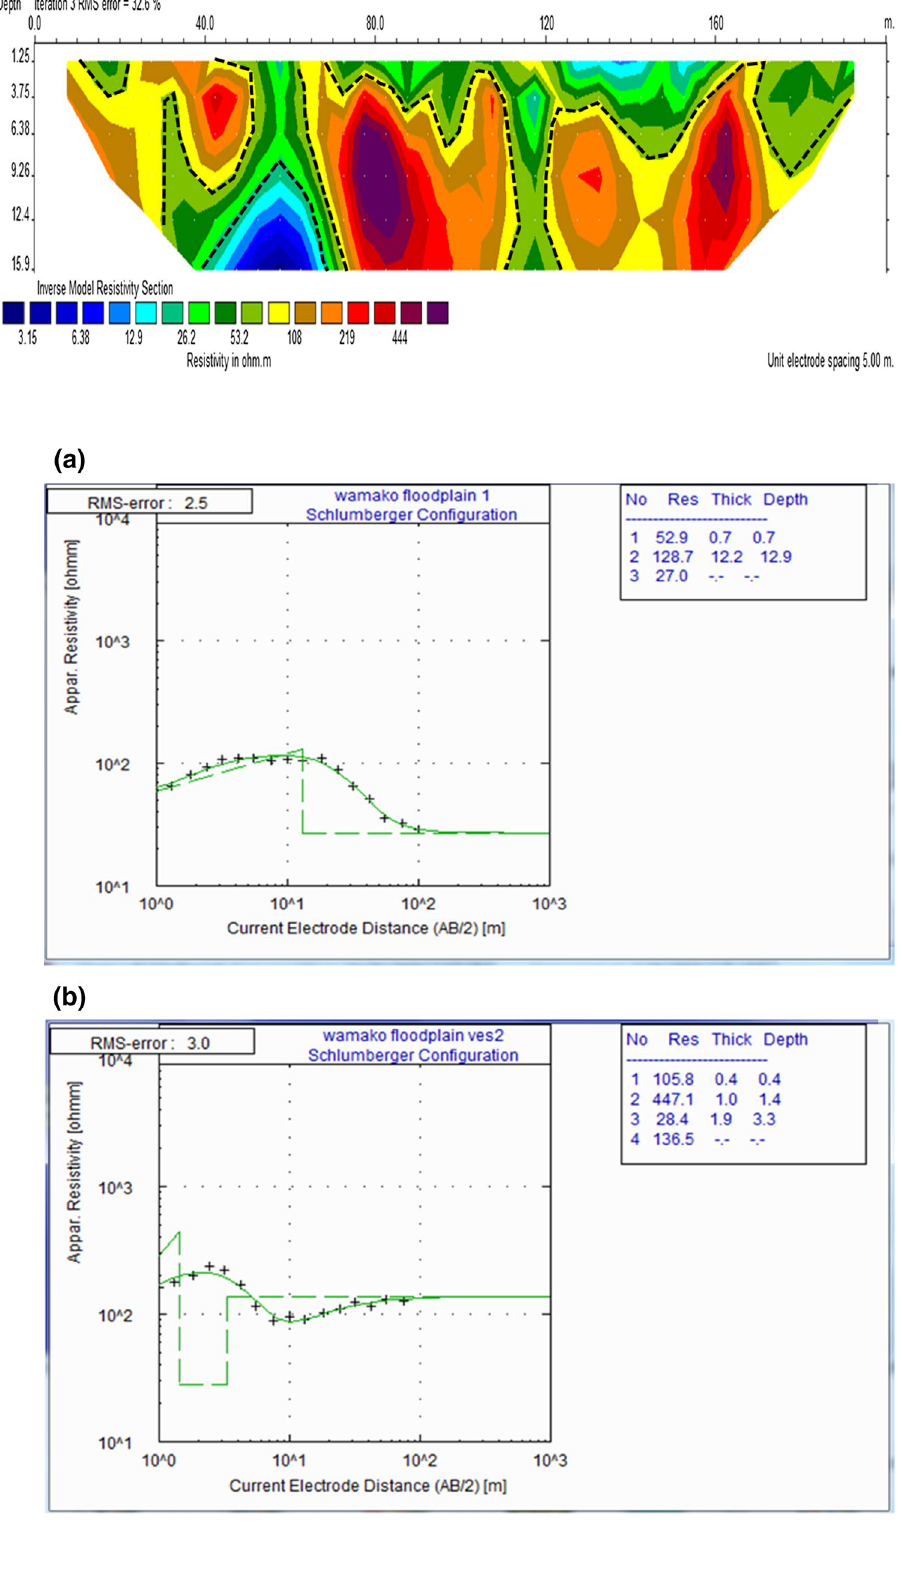
Fig. 7 Pseudosection of profile